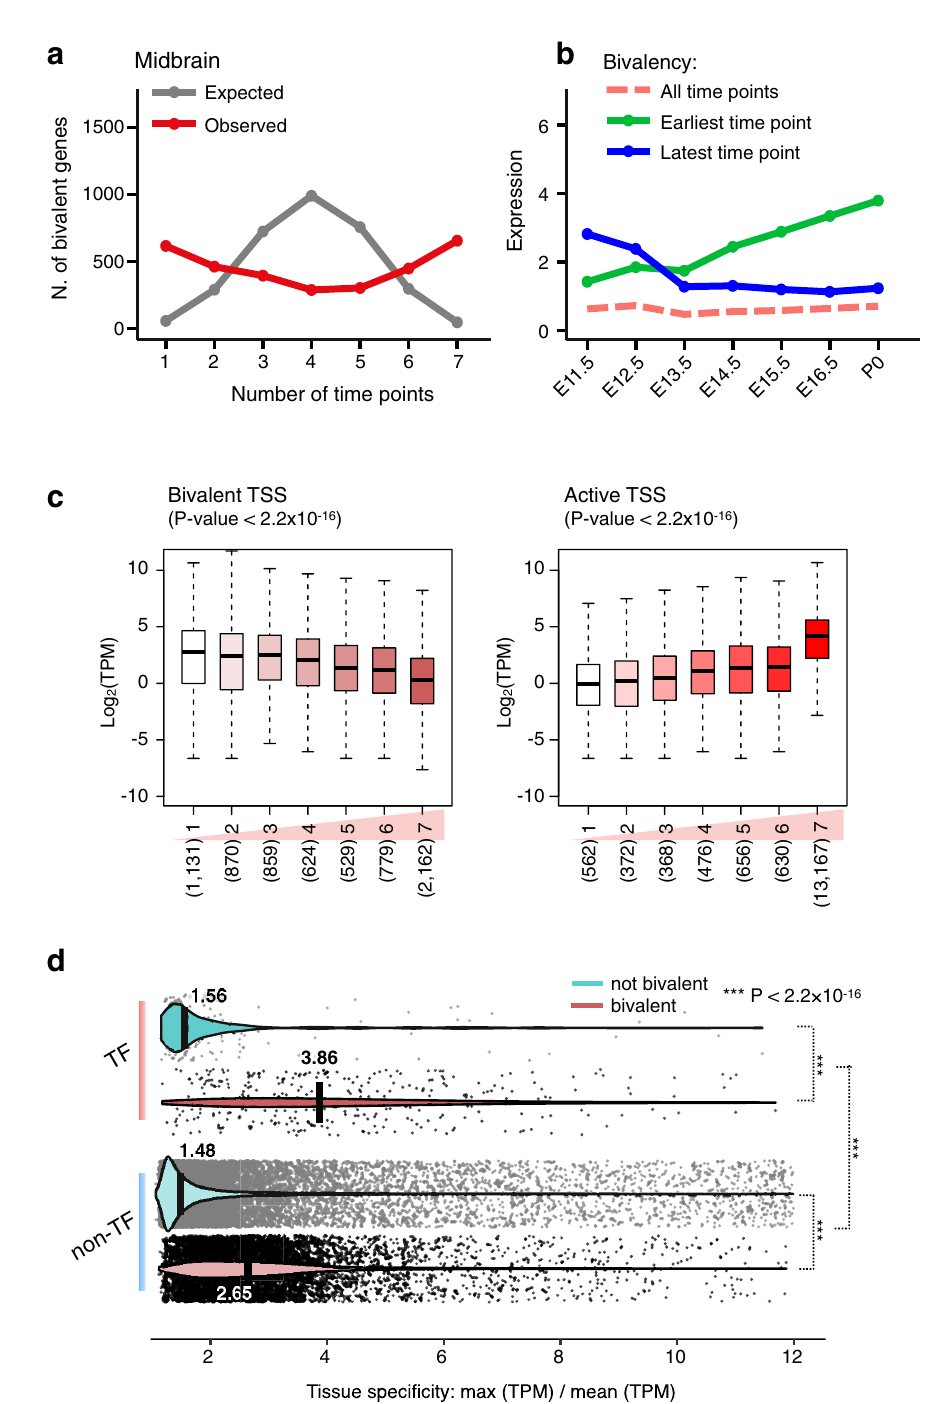
Fig. 3 Count and expression of bivalent genes along developmental timepoints. a The number of bivalent genes at 1 – 7 timepoints in the midbrain. Observed and expected numbers of genes are in red and in gray, respectively. b Median expression levels of three groups of genes: (green) bivalent at the earliest timepoint but not at the last timepoint, (blue) bivalent at the last timepoint but not at the fi rst timepoint, and (pink) bivalent at all timepoints. c Distribution of gene expression, with genes grouped by the total number of timepoints at which their TSSs are in the bivalent state TssBiv (left) or in the active state Tss (right) in the forebrain. The total number of genes in each group is shown below each boxplot in parentheses. For all boxplots, whiskers show 95% con fi dence intervals, boxes represent the fi rst and third quartiles, the vertical midline is the median, and outliers are omitted. There is a negative correlation between expression and the duration of the bivalent state and a positive correlation between expression and the duration of the active state ( P values < 2.2 × 10 − 16 ). d Violin plots show the distributions of tissue speci fi city scores for bivalent and non-bivalent genes that encode transcription factors (TFs) and non-TFs. Medians are shown in black bars with values indicated. P values are shown for three comparisons as